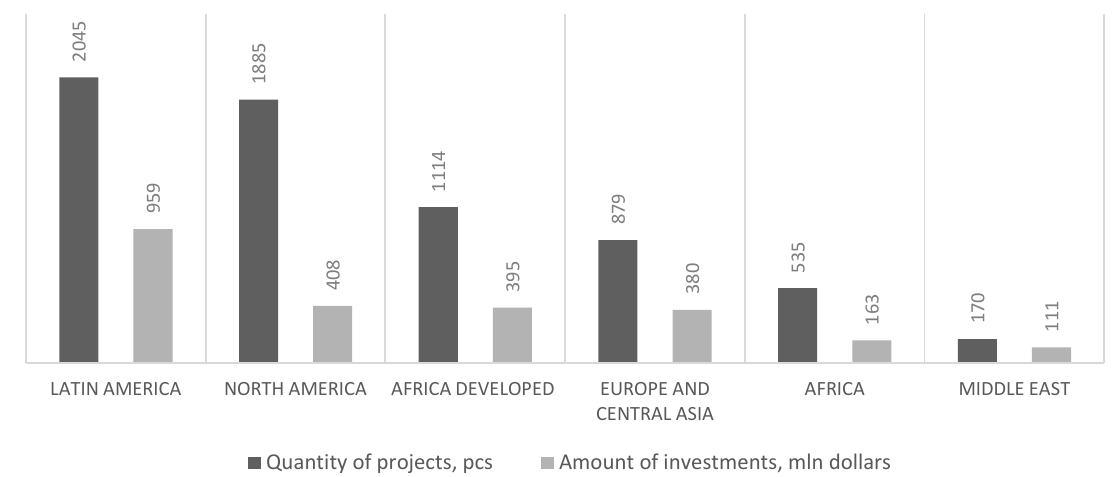
Figure 1. Infrastructural PPP projects for 1990–2017